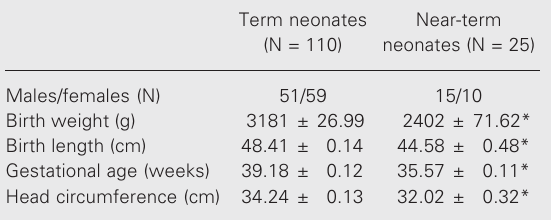
Table 2. Characteristics of the newborns.